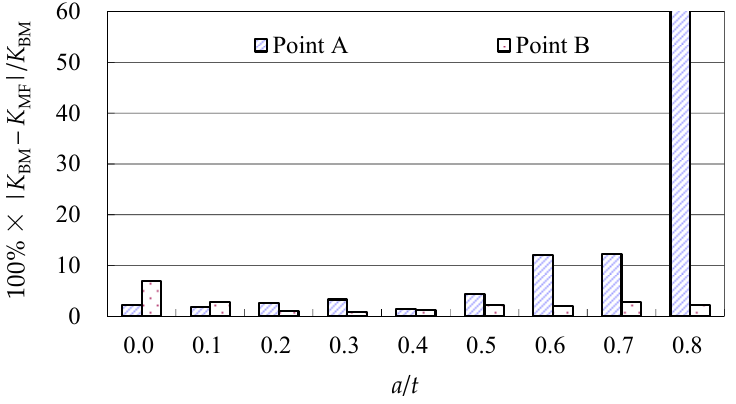
Figure 13. Modified formulae vs. the benchmark results ( a / c = 0.5). Table 2. Modified formulae vs. photo-elastic experiment data.